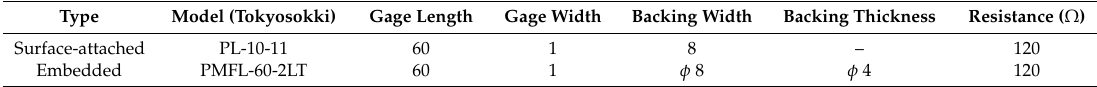
Table 2. Types and characteristics of surface-attached and embedded strain